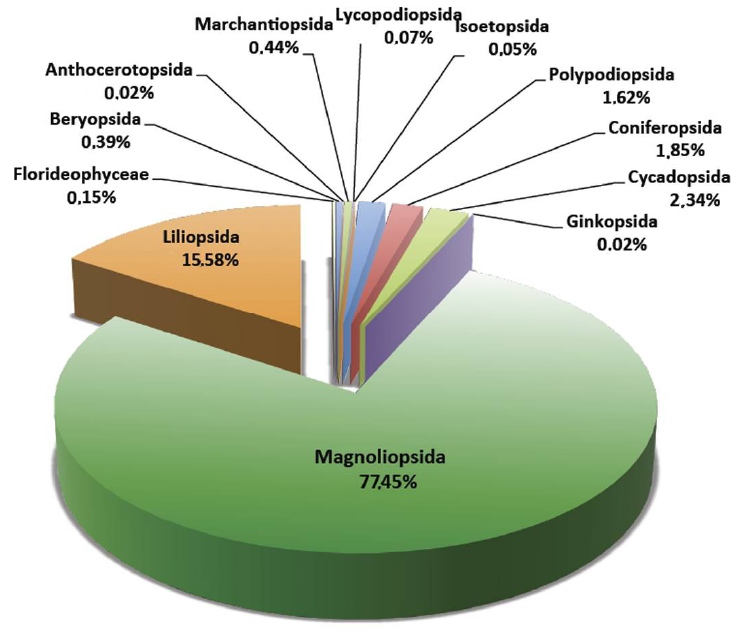
Figure 3. Percentage of the current number of threatened species evaluated in relation to the number of the plant species assessed in the IUCN plant Red List